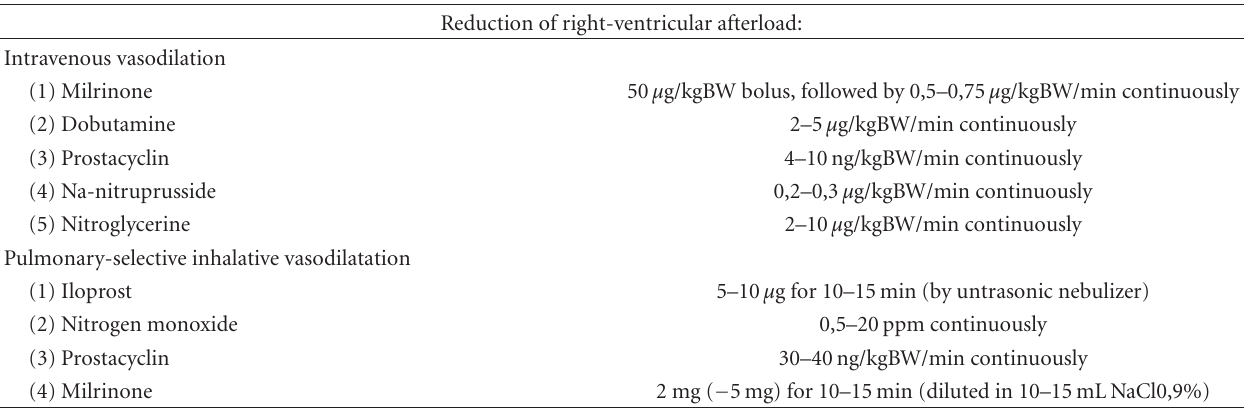
Table 11: Specific interventions for therapy of intra- and/or postoperative increase of pulmonary arterial pressure (mod. [30, 31, 38, 39, 48, 59,